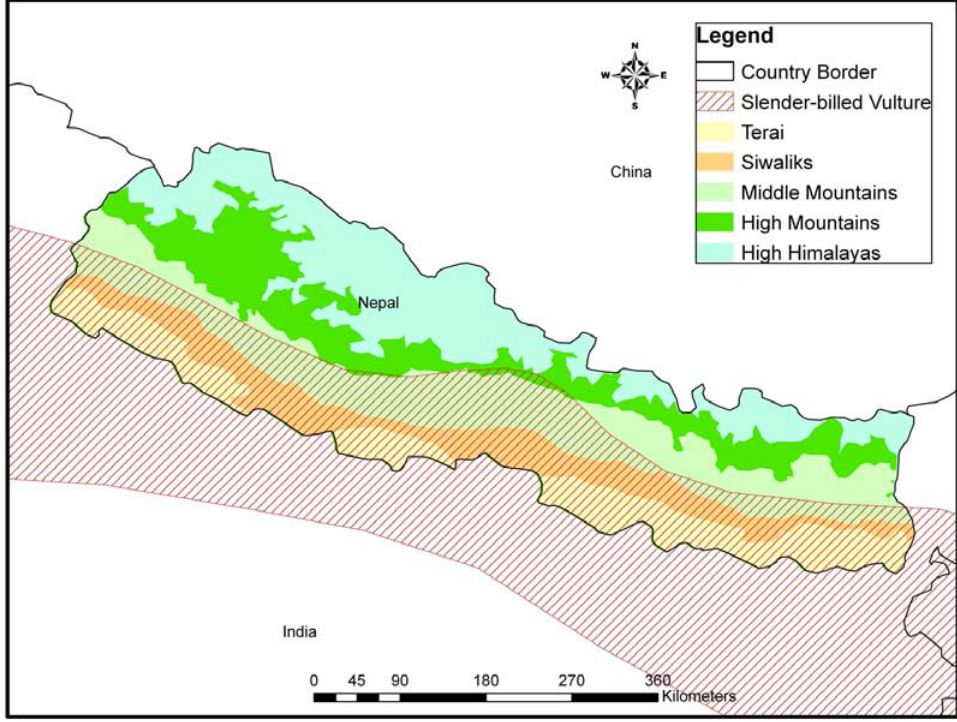
Figure 4. Slender-billed Vulture distribution in Nepal. Adapted from (Birdlife International & NatureServe